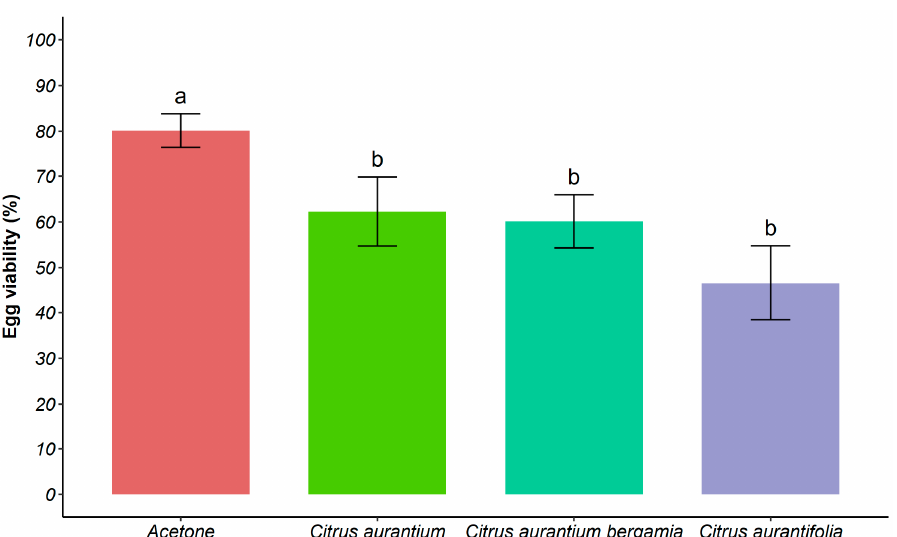
Figure 6. Egg viability (%) of adults of Tuta absoluta treated in the second larval instar with EOs LC 50 Citrus aurantifolia , Citrus aurantium and Citrus aurantium bergamia and only acetone (control). Similar lowercase letters indicate no significant differences between treatments.